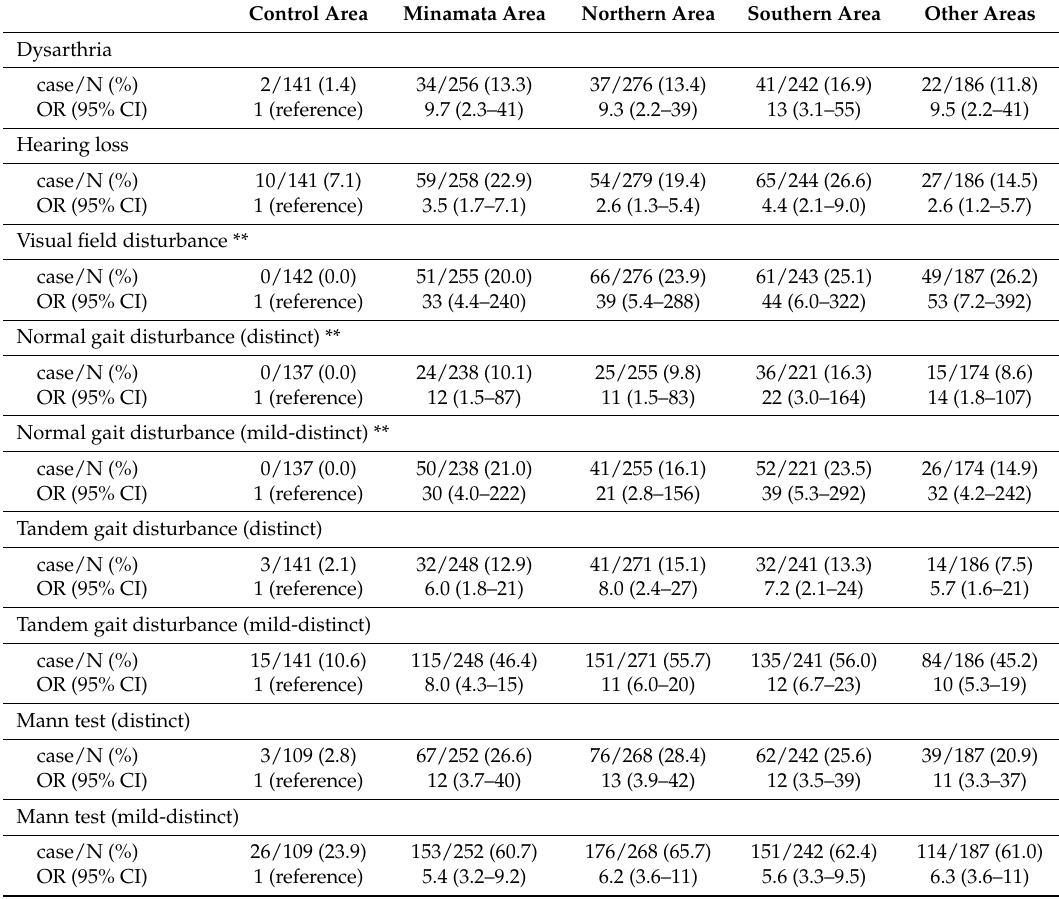
Table 7. Prevalence of neurological findings and adjusted* odds ratios (OR) for the association between area and neurological findings ( n =